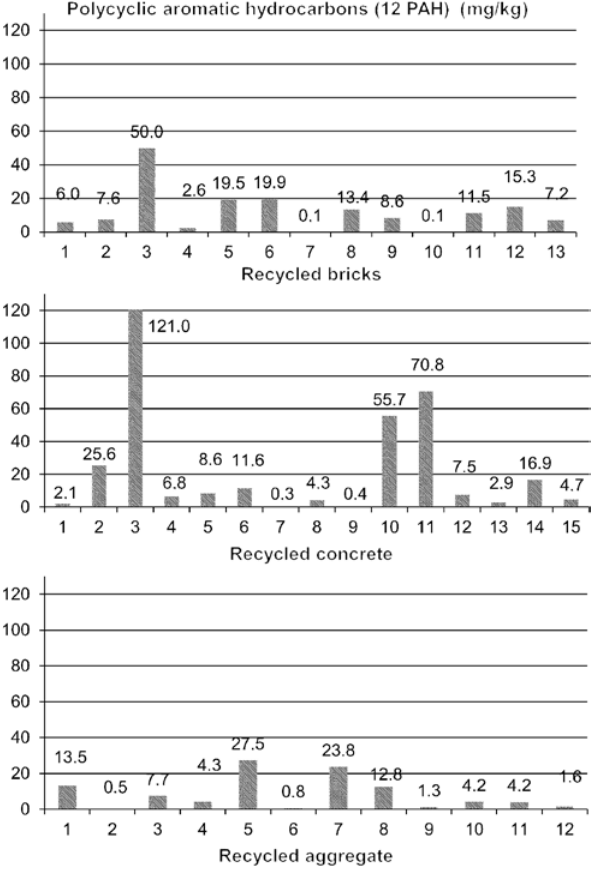
Figure 3: Amount of the 12 PAH sum in tested